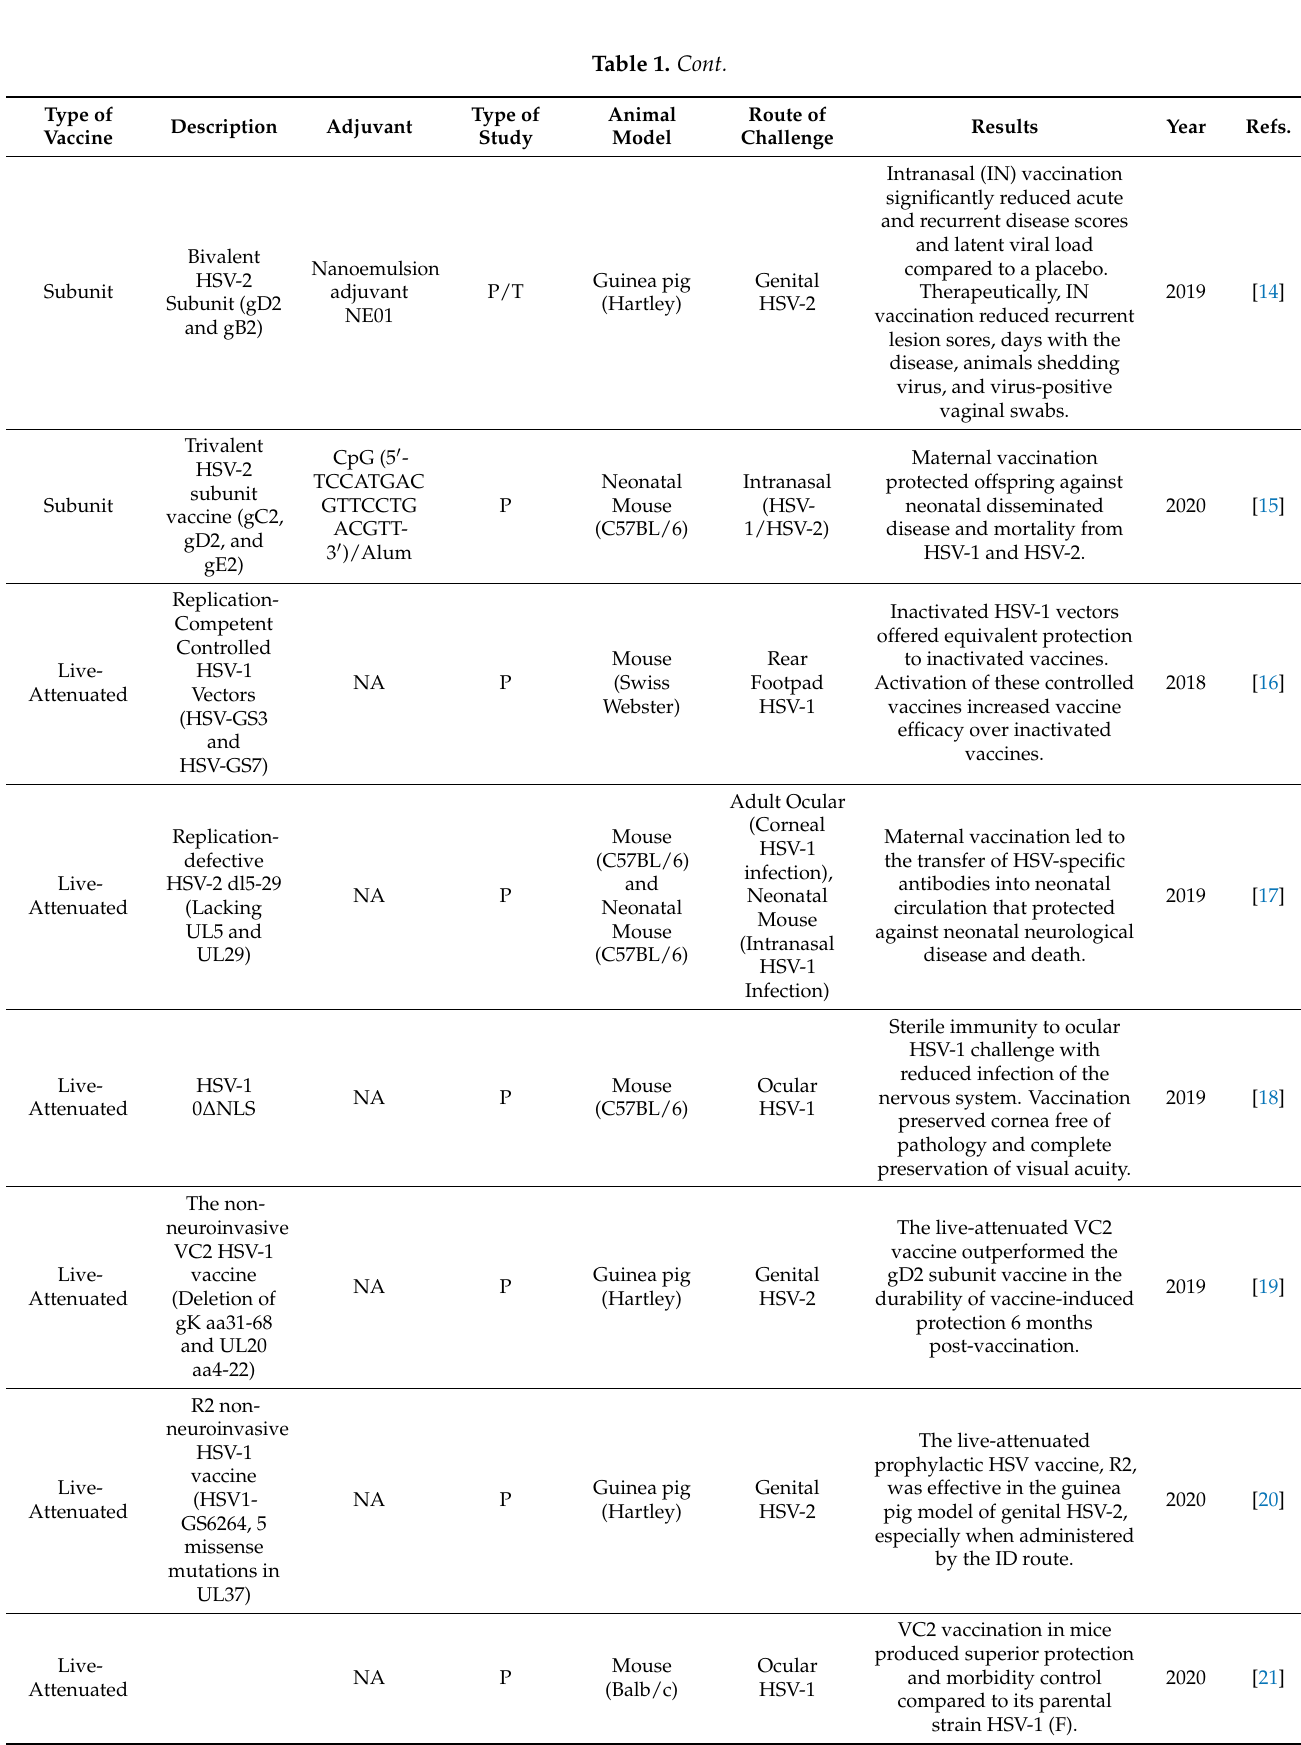
Abbreviations: P—Prophylactic,